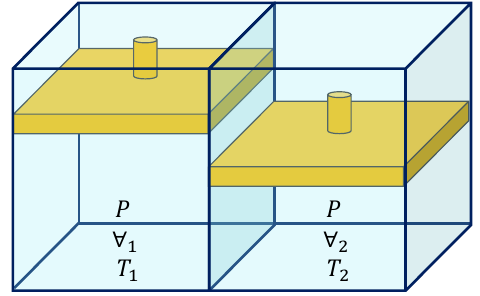
Figure 2. Initial thermodynamic state of the coupled